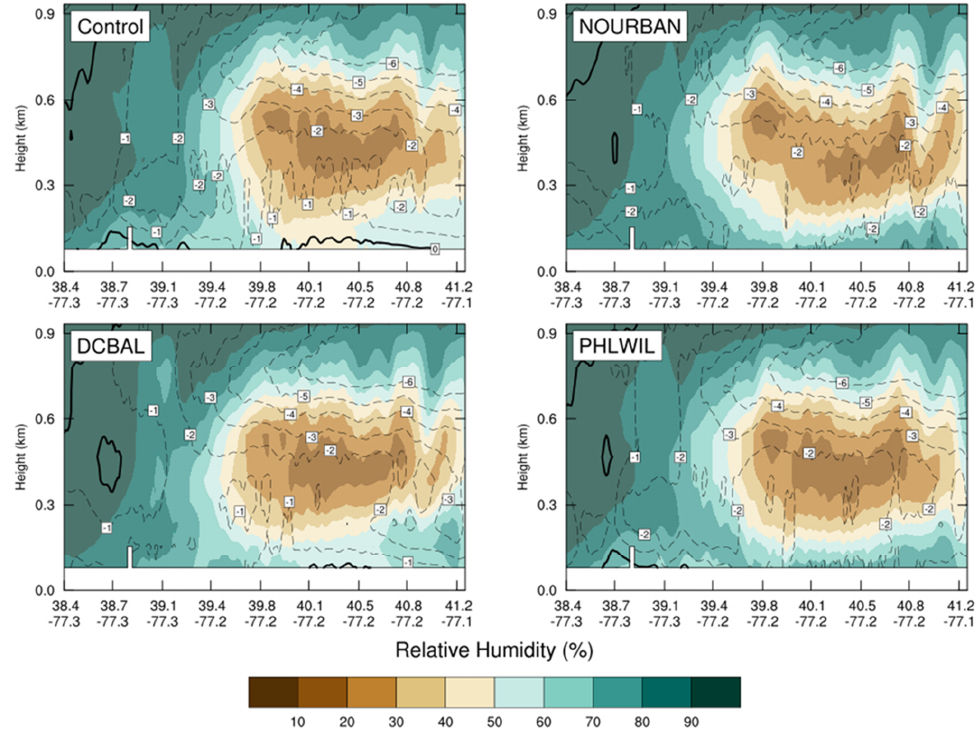
Figure 13. Same as Figure 12 except zoomed into the lowest kilometer of the atmosphere for detail.